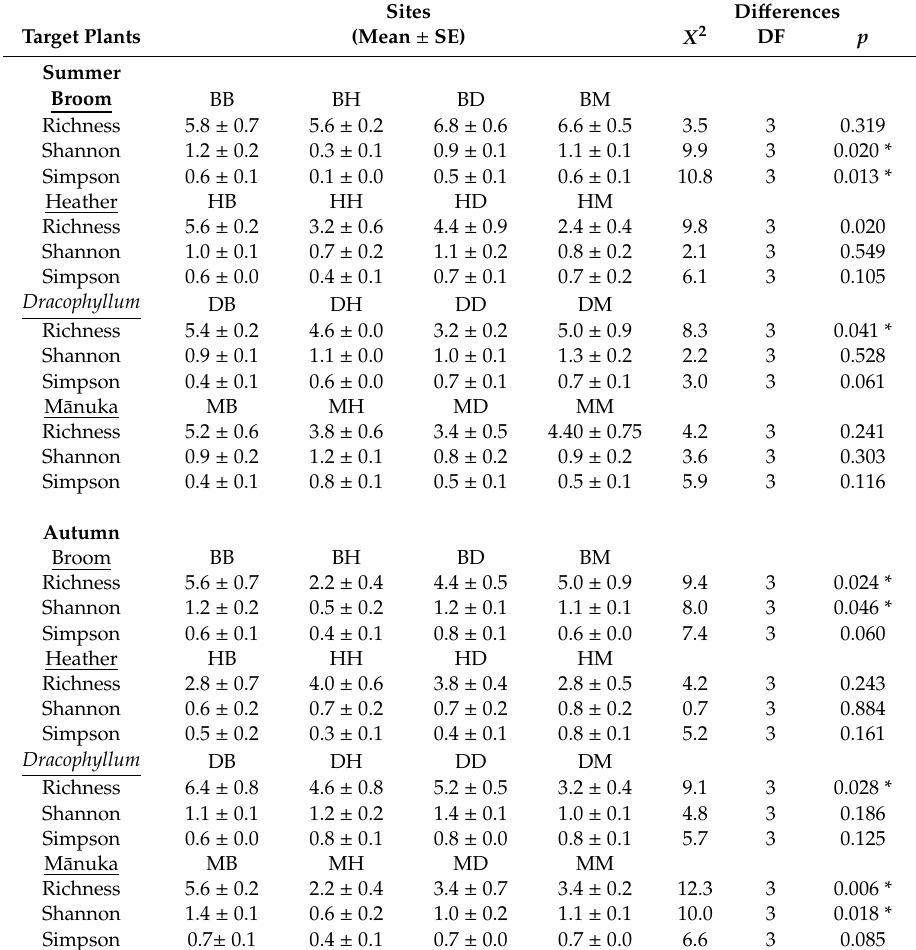
Table 6. Richness, Shannon’s and Simpson’s diversity indices for arthropods (at order level) on each target plant paired with conspecific and heterospecific neighbours in summer and autumn ( n = 5). p -values were calculated using the Kruskal–Wallis